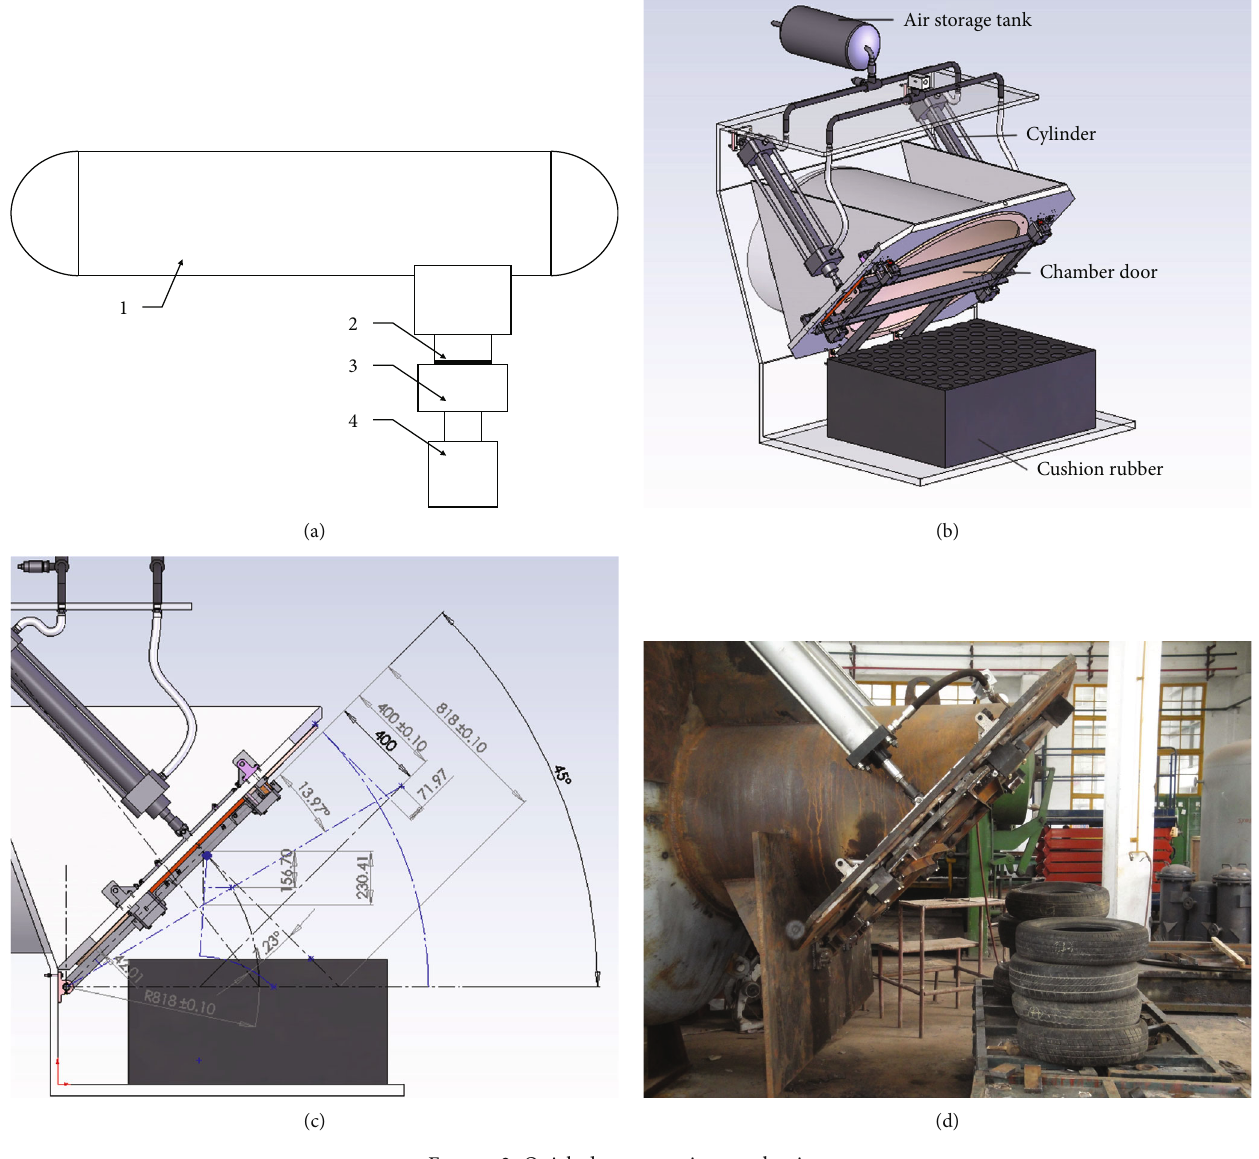
Figure 2: Quick decompression